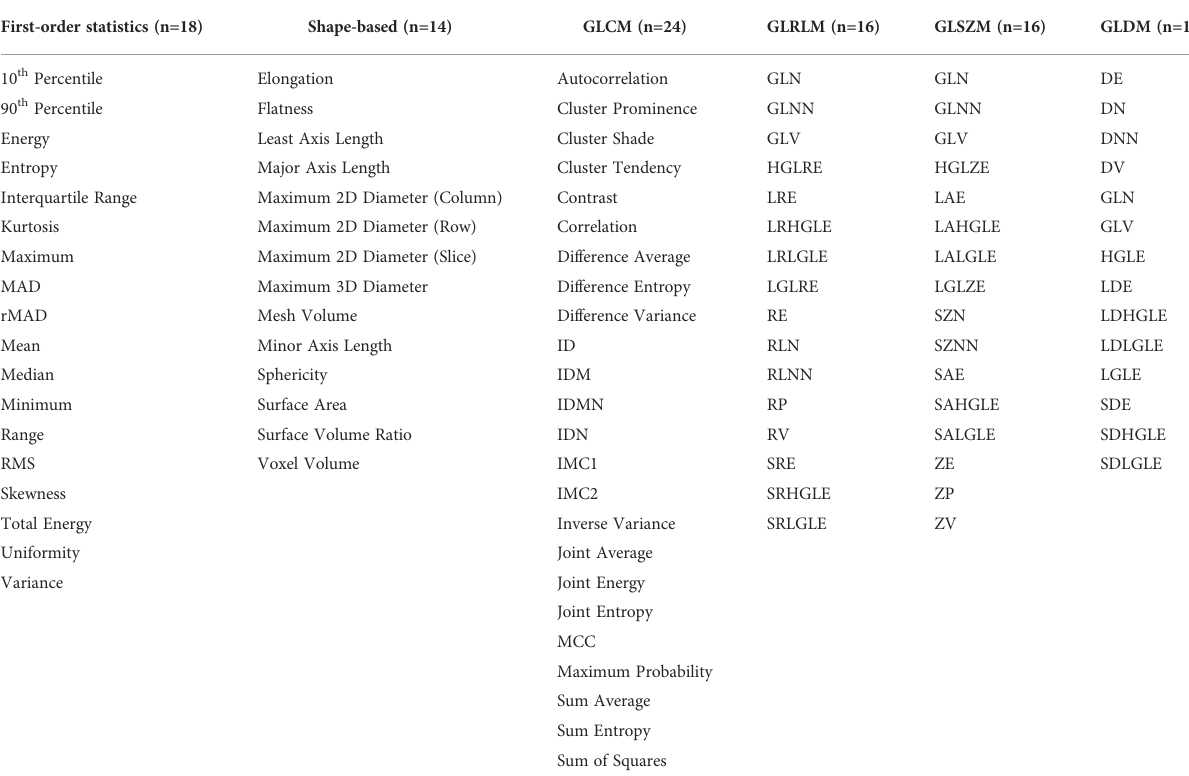
TABLE 1 The list of extracted radiomics